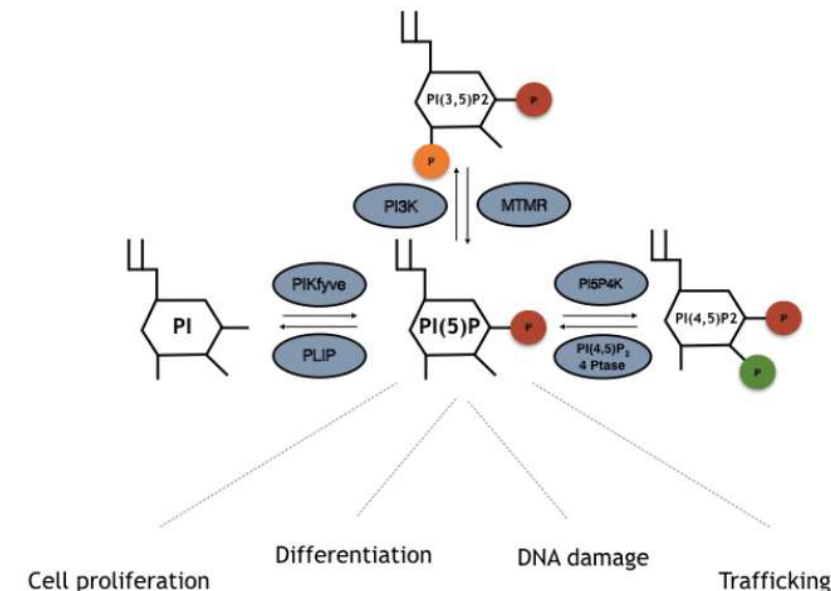
Figure 1. Enzymes involved in phosphatidylinositol 5 phosphate (PI5P) turnover and array of